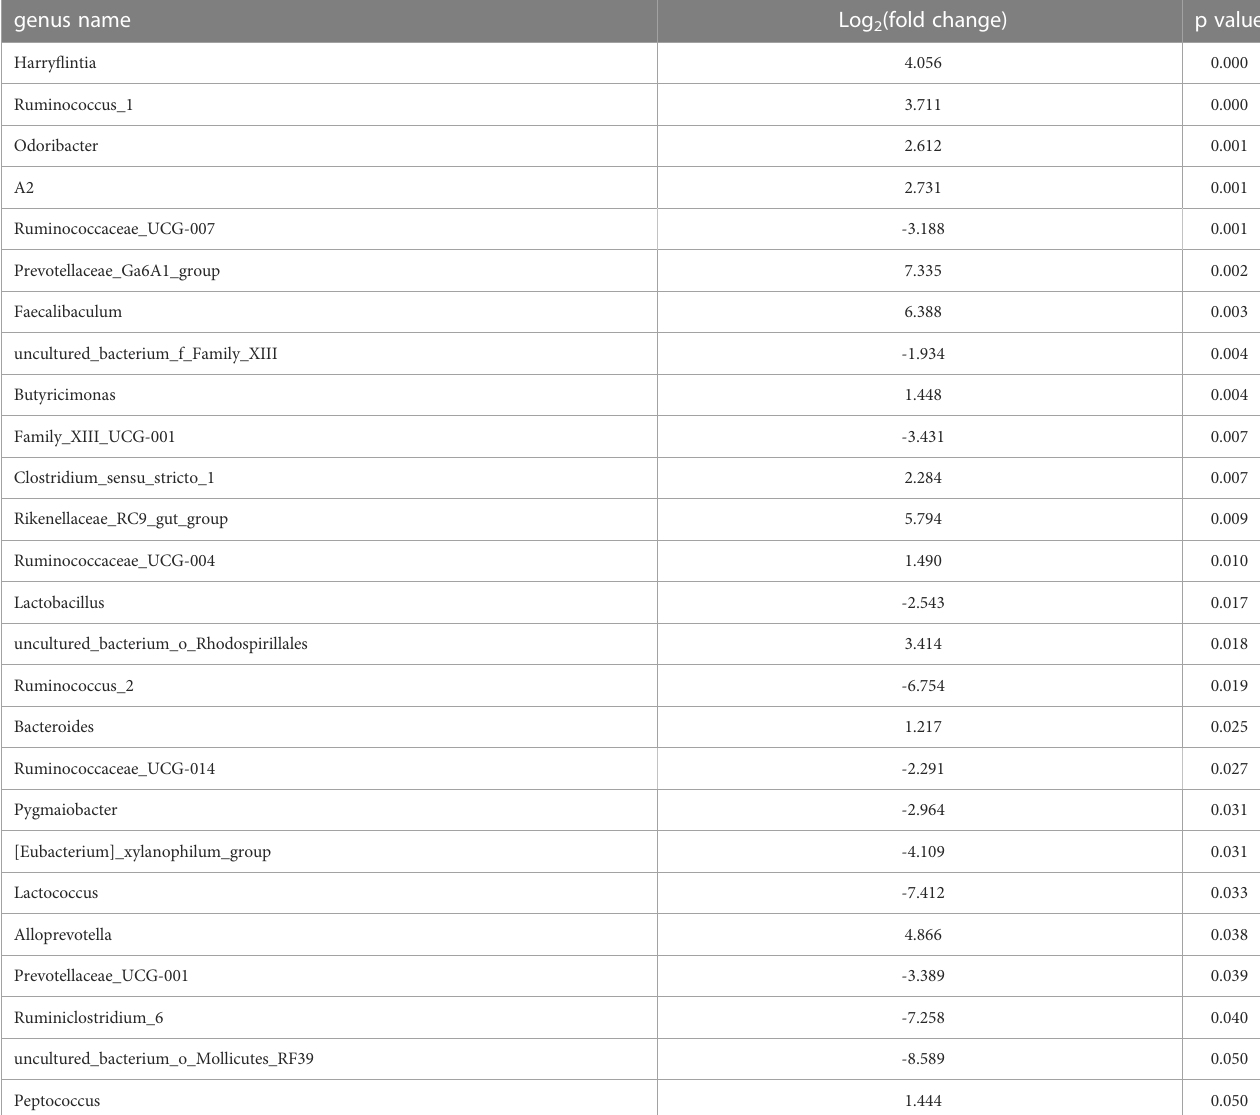
TABLE 1 Signi fi cantly changed gut microbiota between NASH and control groups. genus name